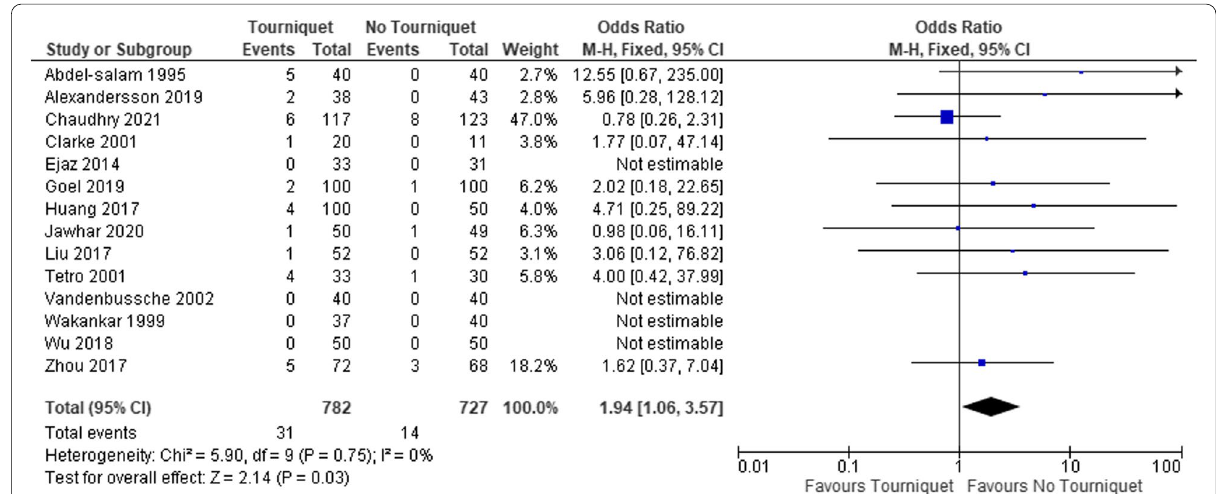
Fig. 4 Comparison of the total infection rate (superficial and deep) between groups